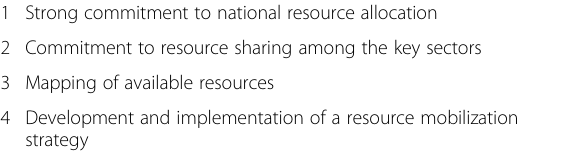
Table 6 Indicators of effective national ownership and leadership of OH Coordination